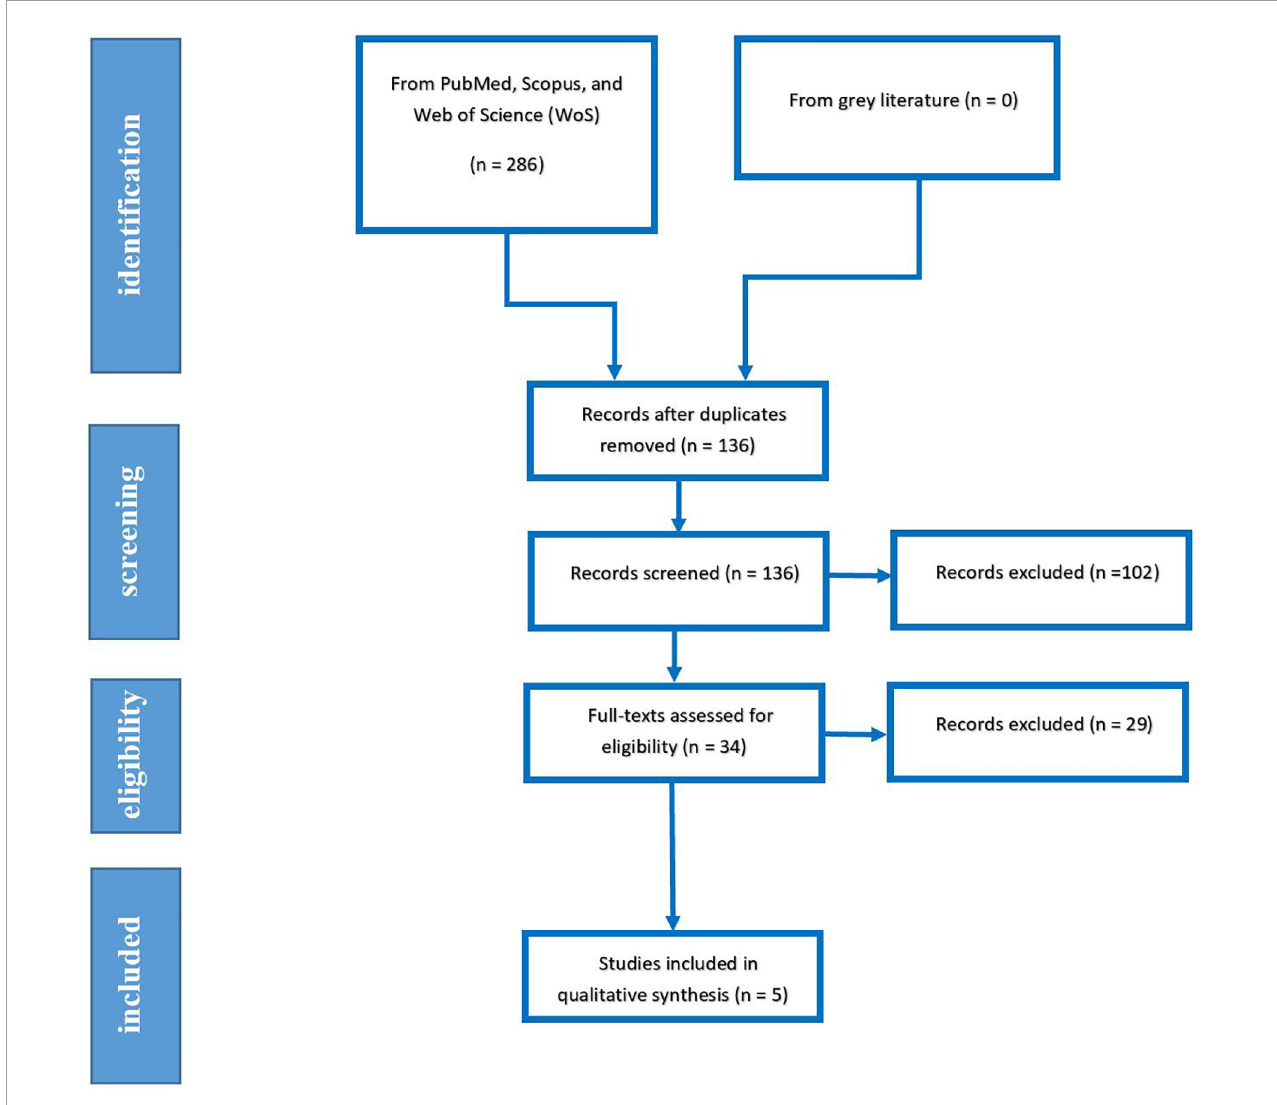
FIGURE1 PRISMA flow